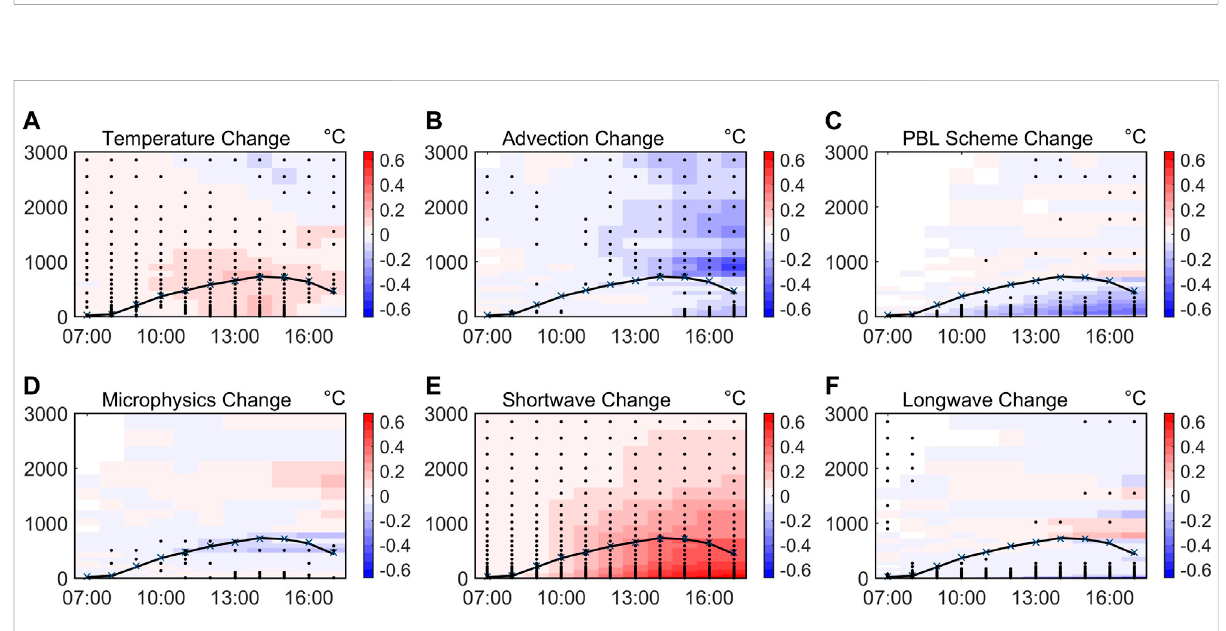
FIGURE 8 Process analysis of ensemble mean temperature change by BC radiative effect in time-height section in the Shanghai case, averaged over the boxregionshowninFigure3D. (A) Simulatedtemperaturechange. (B – F) Simulatedaccumulatedtemperaturechangeduetoadvection,PBLscheme (including surface heat fl ux and vertical turbulent mixing), microphysics process, shortwave heating and longwave heating, respectively. The sum of eachindividual process (B – F) equals tothetotaltemperaturechangein (A) .Black solidlinesrepresent PBLheightinthesimulationwith aerosol radiative feedback (BASE300). Bluecrosses represent PBLheight in thesimulation with aerosolradiative feedbackexcept BC.(AeroRadexBC). Stilted grids indicate signi fi cant differences at the 5% signi fi cance